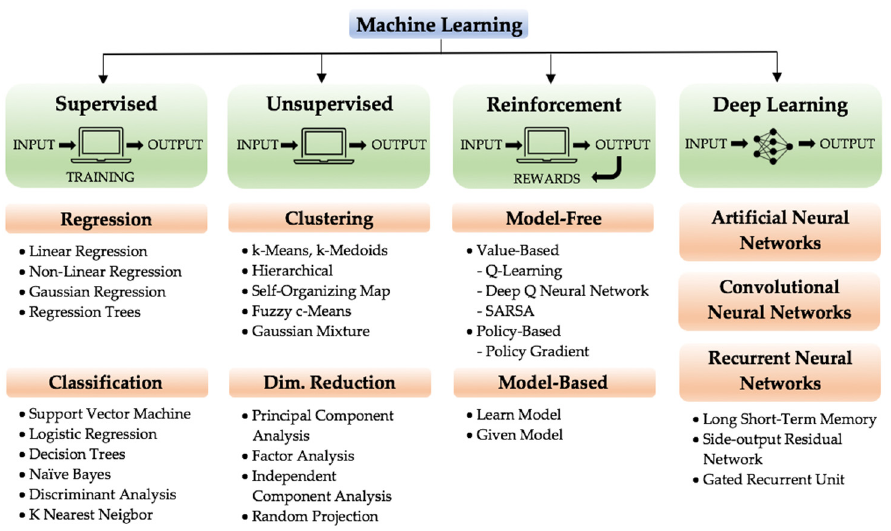
Figure 5. Machine learning algorithms divided into supervised, unsupervised, reinforcement, and deep leaning methods.